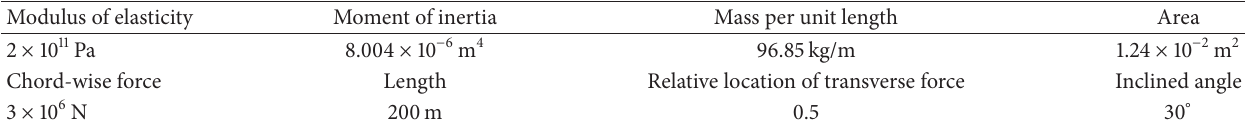
Table 1: Basic parameters of the cable.